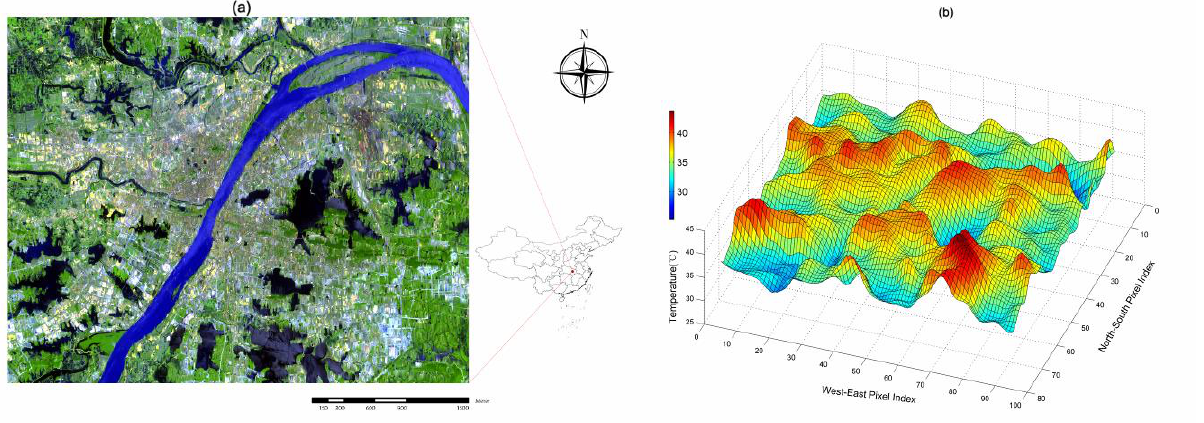
Figure 1: Study Area and its latent LST. (a) The study area represented by false colour image. SWIR2, NIR, and Green bands of Landsat ETM+ are combined to highlight the land surface heterogeneity of built environment, vegetation and water bodies. (b) The latent LST at 1330h, July 27th, 2012 extracted by using Gaussian Process model.